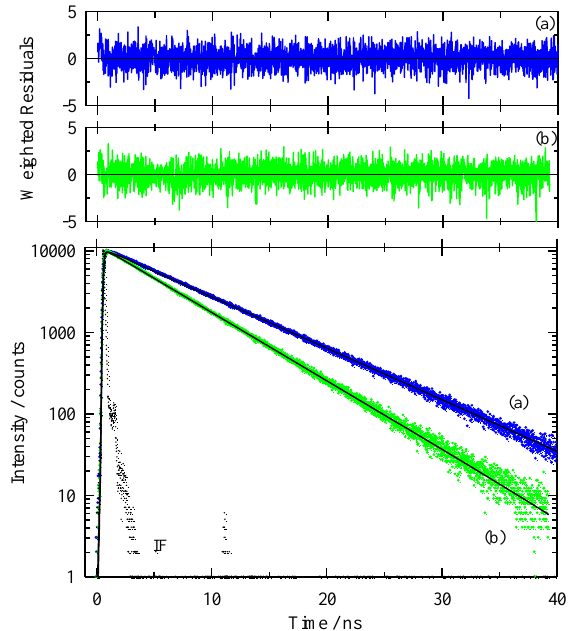
Figure 6. C153/scCO 2 intensity decays at 323 K; excitation was at 24,691 cm −1 with emission at 22,222 448 Figure 6. C153 / scCO 2 intensity decays at 323 K; excitation was at 24,691 cm − 1 with emission at 22,222 cm − 1 . cm −1 . In the lower panel, dots are the measured decays and the solid lines are the resulting fits. The 449 In the lower panel, dots are the measured decays and the solid lines are the resulting fits. The label “IF” ChemEngineering 2019 , 3 , x FOR PEER REVIEW label “IF” shows the instrument response function. Blue trace “a” was at  r = 0.571 and green trace 450 shows the instrument response function. Blue trace “a” was at ρ r = 0.571 and green trace “b” was at “b” was at  r = 1.659. The upper panels are the residuals to the sum-of-exponentials model with two 451 ρ = 1.659. The upper panels are the residuals to the sum-of-exponentials model with two time constants. r time constants. 452 Sample decays at  r = 0.754 (blue trace “c”) and  r = 1.726 (green trace “d”) for C153 in [P 6,6,6,14 ] + 453 [Tf 2 N] − /scCO 2 are in Figure 7. Again, a sum-of-exponentials model was used to fit the decays with the 454 shorter time constant used to account for scattered photons. The residuals show that at low density 455 (Figure 7, panel (c)), a single time constant is not completely adequate to describe the intensity decay, 456 whereas, at high density (Figure 7, panel (d)), there is very little difference between the one and the 457 two component models. We noted improved fits were achieved by including a second time constant 458 as evidenced by both the diminution of  r2 and by increased randomness in the residuals and their 459 autocorrelations (not shown). Comparing the neat scCO 2 and IL/scCO 2 traces, it is immediately clear 460 that the C153 lifetime is significantly shorter in the presence of IL. 461